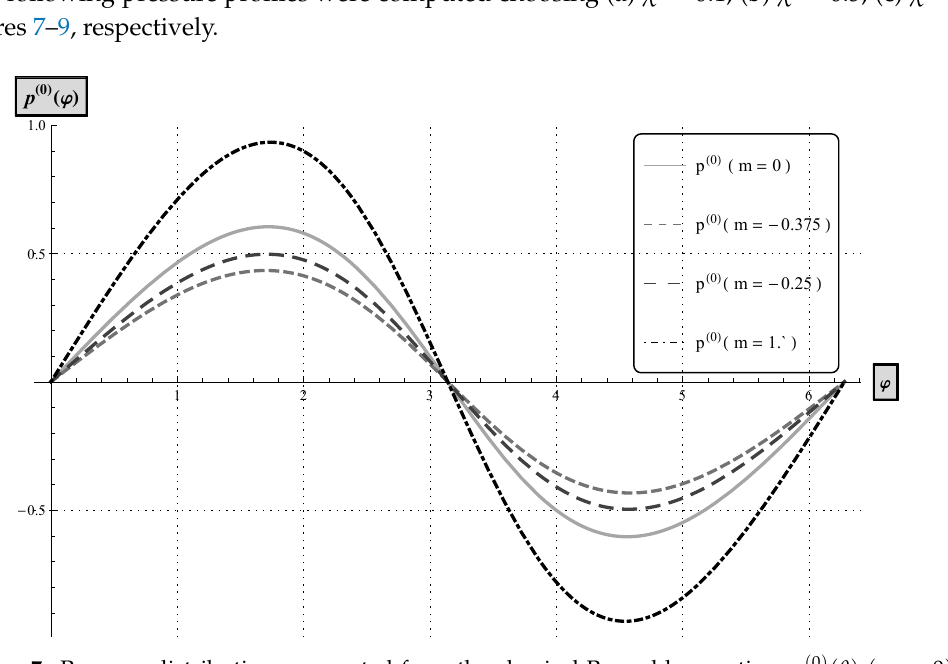
Figure 7. Pressure distributions computed from the classical Reynolds equation, p ( 0 ) ( θ ) ( m = 0 ) , and from the power-law system of Reynolds type equations, p ( 0 ) ( θ ) ( m = − 0.375, − 0.25, 1 ) , with χ =